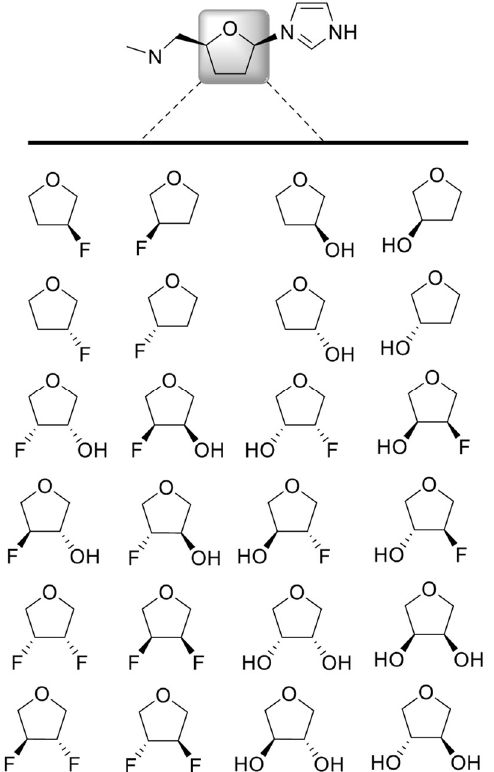
Figure 2. Set of 24 test (T) furanose ring structures used to derive partial charges and parameterize torsional variables.